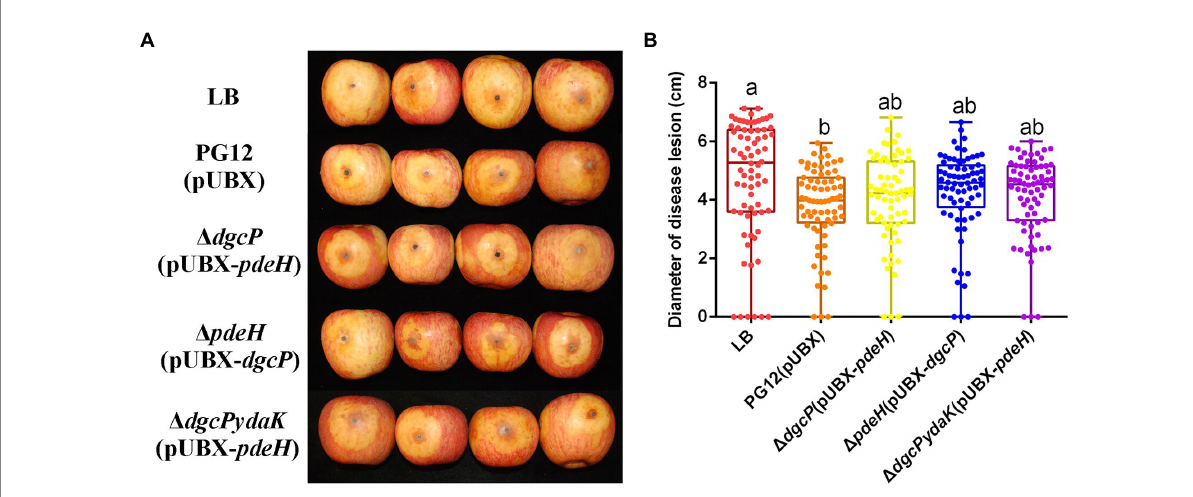
FIGURE 5 The biocontrol efficacy of the supernatants of B. velezensis PG12(pUBX) and its derivatives against apple ring rot disease. Bacteria were incubated for 48 h in LB broth supplemented with 1% (w/v) xylose at the final concentration. The cell-free supernatants were obtained after centrifugation at 6,000 ×g for 20 min at 4 ° C, and then filtration using a 0.22- μ m pore size filter. Biocontrol efficacy was assessed with Fuji apple fruits treated with the supernatants of B. velezensis PG12(pUBX) [PG12(pUBX)], Δ dgcP (pUBX- pdeH ), Δ pdeH (pUBX- dgcP ), or Δ dgcPydaK (pUBX- pdeH ). LB broth (LB) was used as control. Images were taken (A) and the diameter of disease lesions (B) was measured 7 days post inoculation. Values correspond to the mean diameter of 80 disease lesions from 20 apple fruits. The data is a representative of three independent experiments. Different letters on the column indicate significant differences between different treatments according to the least significant difference (LSD) test ( p <